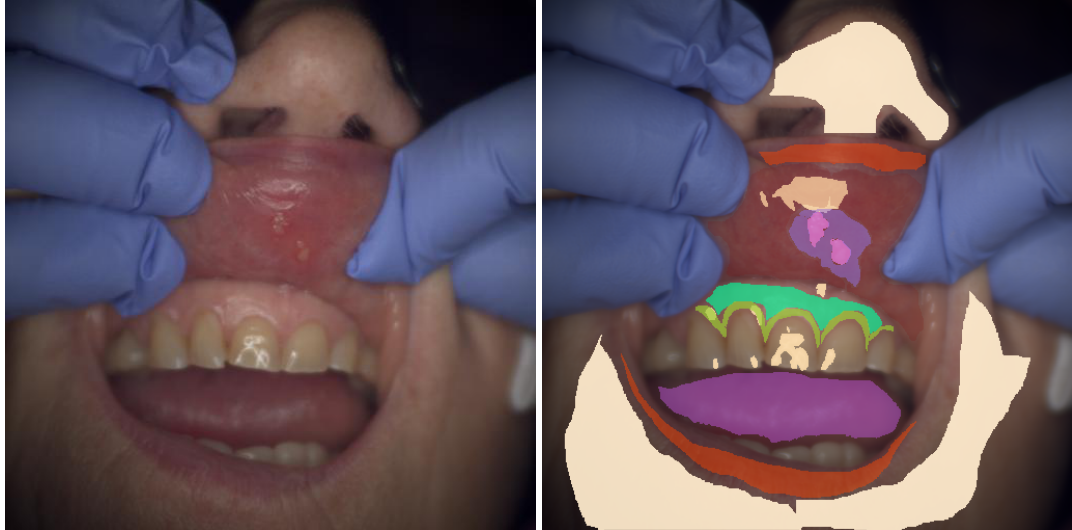
Figure 8. Soft-tissue labeling example: tongue (purple), lips (orange), marginal gingiva (yellow green), attached gingiva (spring green) oral mucosa (red), inflammation (purple), ulcer (pink), skin (off-white). Specular reflections (off-white) on teeth and oral mucosa are also